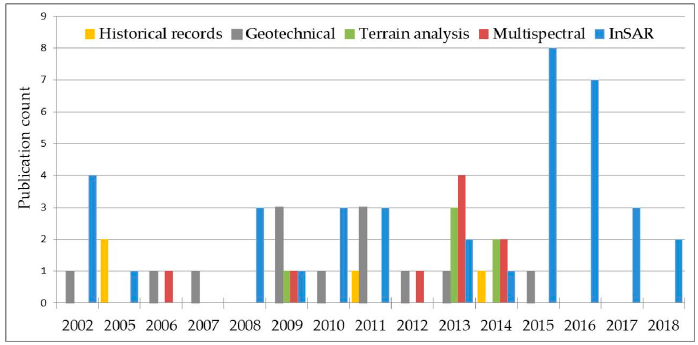
Figure 8. Frequency of publication of referenced sinkhole investigations that aim to build inventories or detect precursors, categorized by the main investigation method; compiling historical records in yellow, geotechnical and in situ investigations in grey, remotely sensed terrain models in green, multispectral image analysis (including aerial imagery) in red and InSAR in blue.